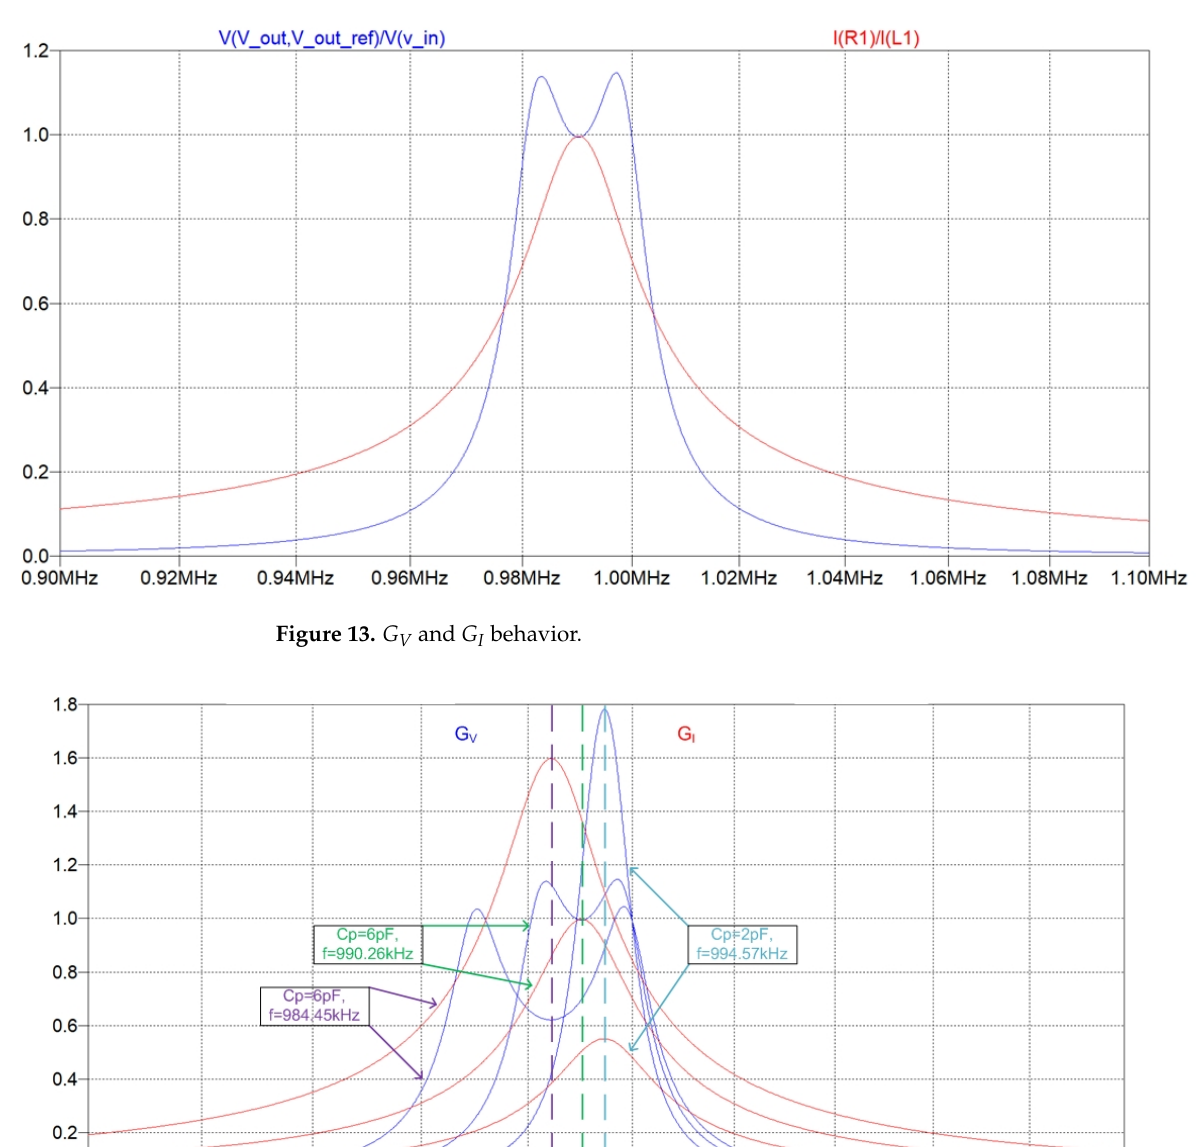
Figure 14. G V and G I behavior for different C p values.